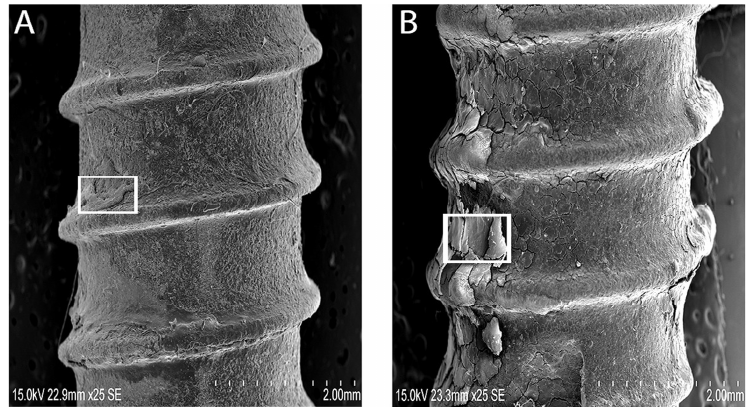
Figure 2. ( A ) SEM images from the surface of ST groups; ( B ) Presence of bone-like augments can be identified (white box) within the implant serrations. The boxed regions represent the area of Raman spectroscopy where part of hydroxyapatite bone formation was analyzed.